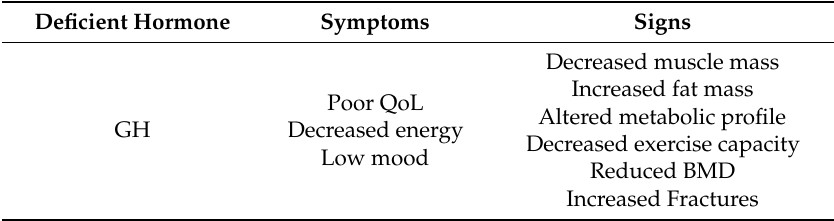
Table 3. Signs and symptoms of growth hormone